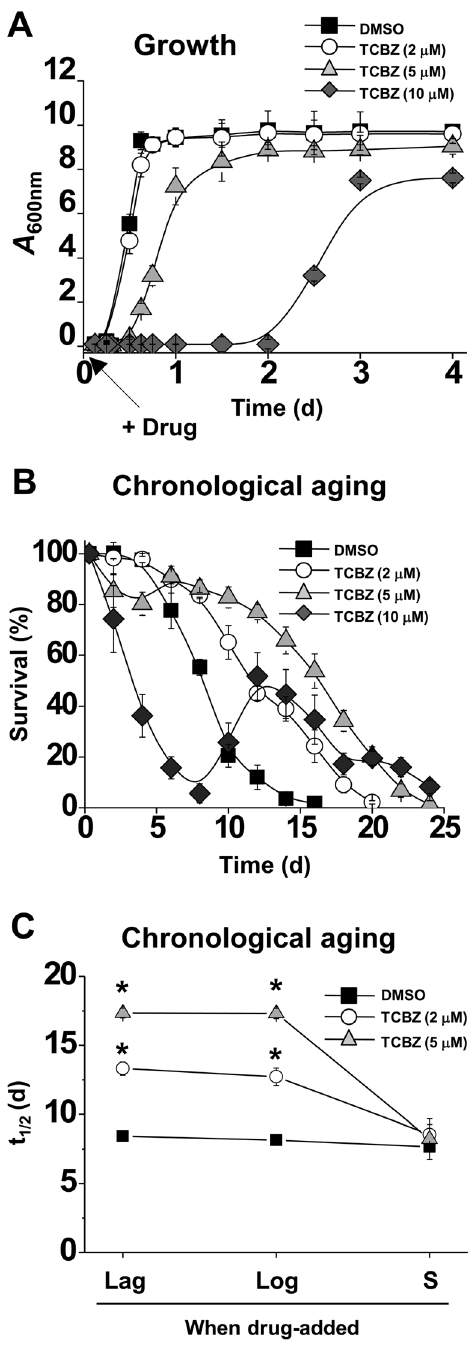
Figure 1. Triclabendazole extends the yeast chronological life span. (A) Growth with triclabendazole or vehicle (DMSO, 0.1%). Drug was added during lag-phase (arrow). Values are the mean 6 standard deviation (SD) of the three independent experiments. (B) Chronological aging assay (survival as a function of time). Drug was added during lag- phase, and then cells were pre-grown for 48 h (= day 0 of life span assay) (2, 5 m M DMSO and triclabendazole, TCBZ) or for 72 h (= day 0 of life span assay) (10 m M triclabendazole). Viability was measured as a function of time. Values are the mean 6 SD of the four independent experiments. (C) Plot of life span versus phase when drug was added. Life span values ( t 1/2 ) are the mean 6 SD of the four independent experiments. *, p , 0.001 (versus